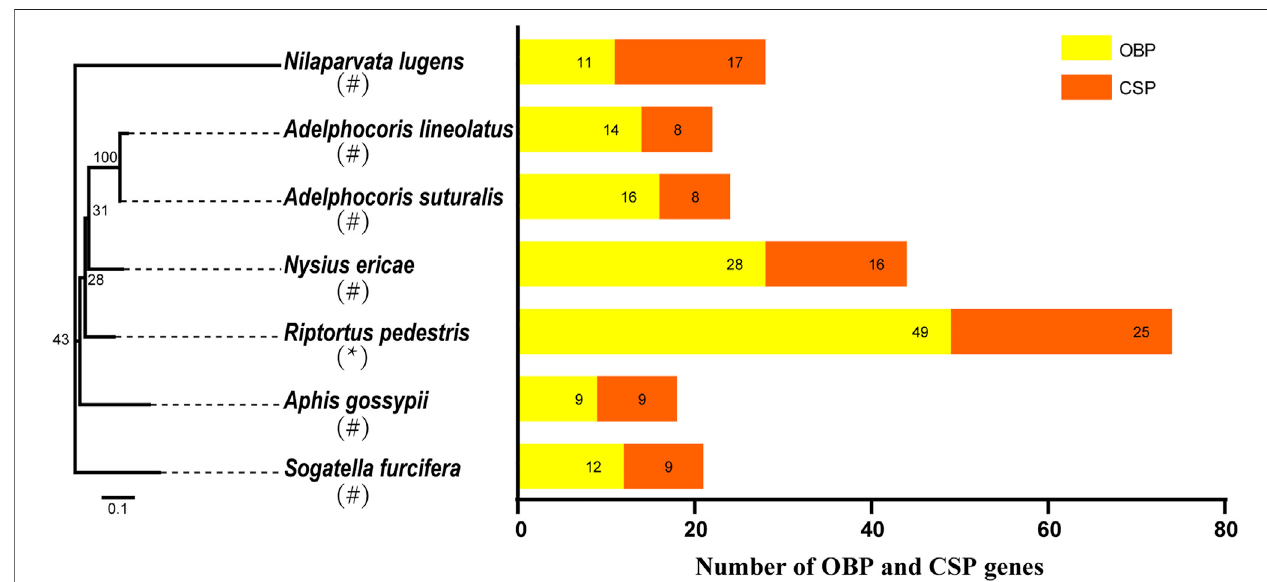
FIGURE1| ThenumberofOBPandCSPgenesindifferentinsectspecies,obtainedfromgenome(*)orantennaltranscriptome(#).Thedigitsbythehistogrambars represent number of OBP and CSP genes in different hemipteran species ( Aphis gossypii , Nilaparvata lugens , Sogatella furcifera , Adelphocoris lineolatus , Adelphocoris suturalis , Nysius ericae , R. pedestris ) and phylogenetic tree was built by these hemipteran species COI genes.